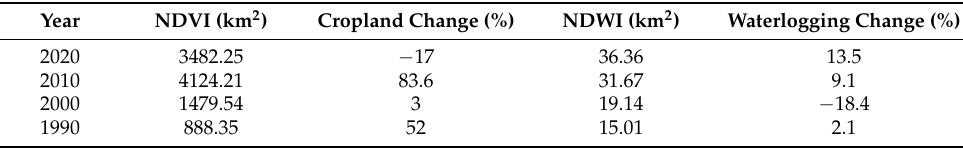
Table 2. Decadal cropland and waterlogged land areas from 1985 to